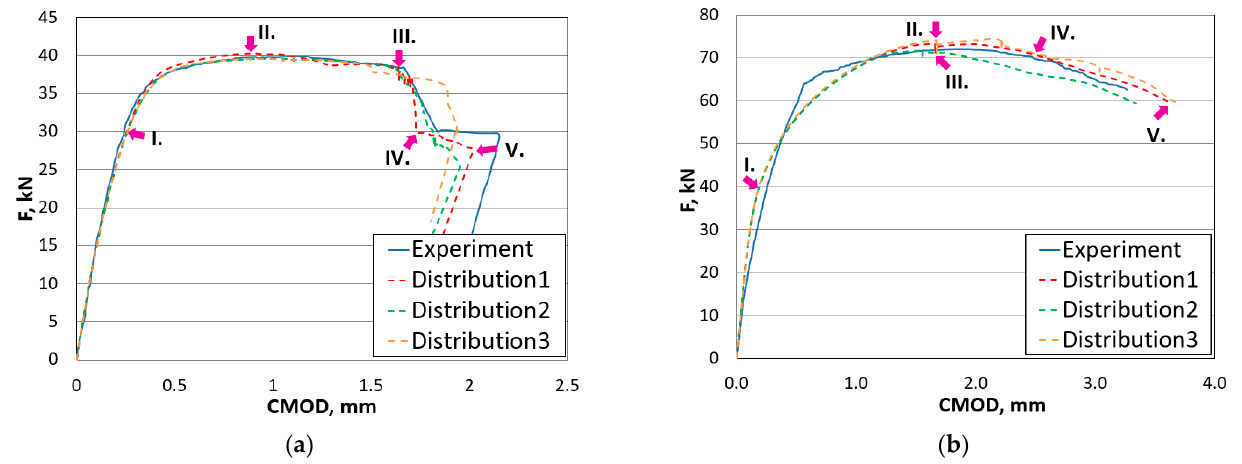
Figure 10. Loading curves for both specimens obtained by experimental measurements and numerical simulations: ( a ) UM/OM configuration 1 (initial crack in UM); ( b ) OM/UM configuration 2 (initial crack in OM).